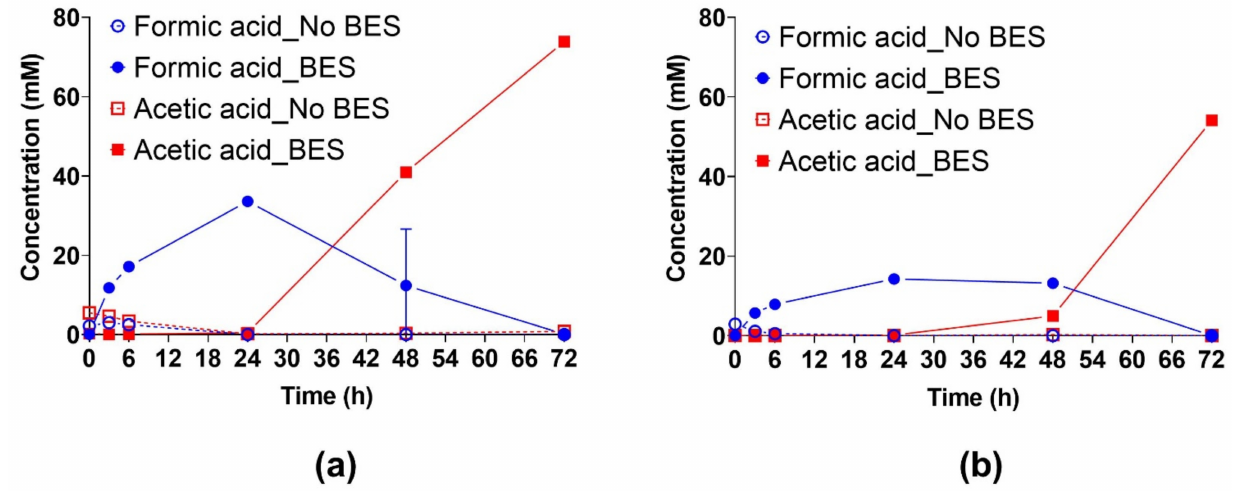
Figure 2. The effect of methanogenesis inhibition by BES (50 mM) on the production and consump- tion of formate and acetate by anaerobic granules in batch cultures with medium A ( a ) and B ( b ). Experimental conditions were as specified in Figure 1. The error bars depict the standard deviation of the mean of n = 3 for non-inhibited cultures and n = 5 for inhibited cultures. When not visible the error bars are smaller than the symbol. Blue circles: formate, red squares: acetate, filled symbols: BES added, open symbols: